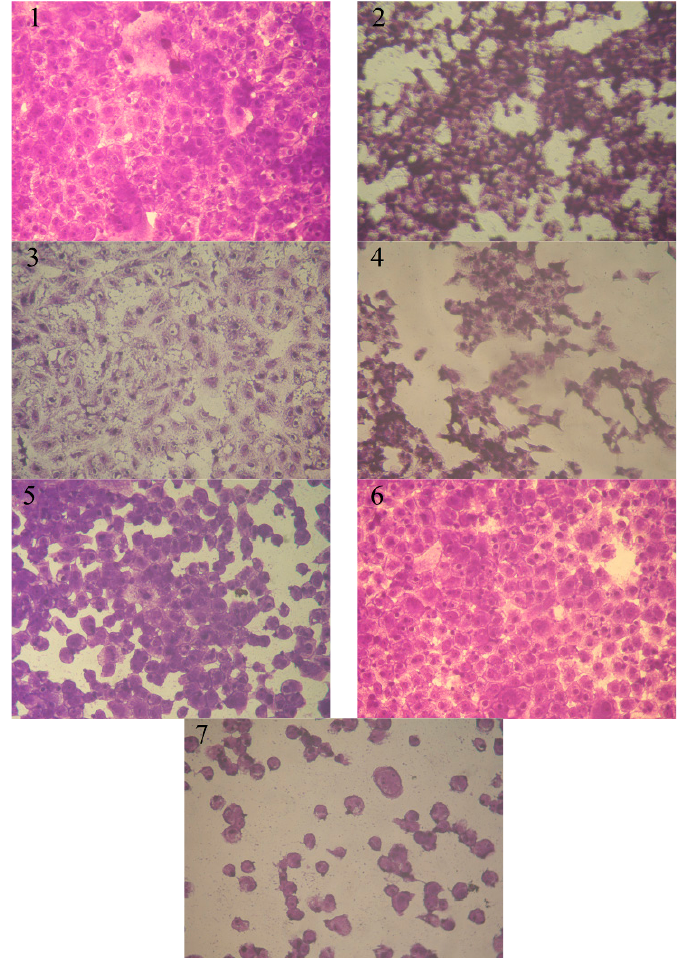
Figure 1. Effect of various concentrations of tested compounds on HepG-2 cell inhibition activity. (1) Control HepG-2 (2) compound 6 (7.8 µg/mL), (3) compound 14 (7.8 µg/mL), (4) compound 14 (125 µg/mL), (5) compound 6 (125 µg/mL), (6) compound 6 (500 µg/mL), (7) compound 12 (7.8 µg/mL), (8)